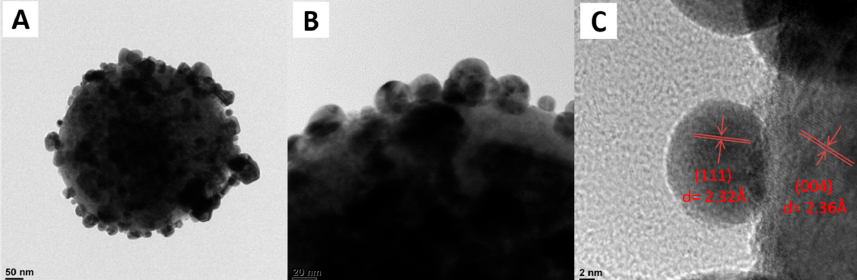
Figure 2. TEM image ( A ) and high resolution TEM image ( B ) and ( C ) of 1.18 wt% Au-1.07 wt% Ag-decorated TiO 2 composites.